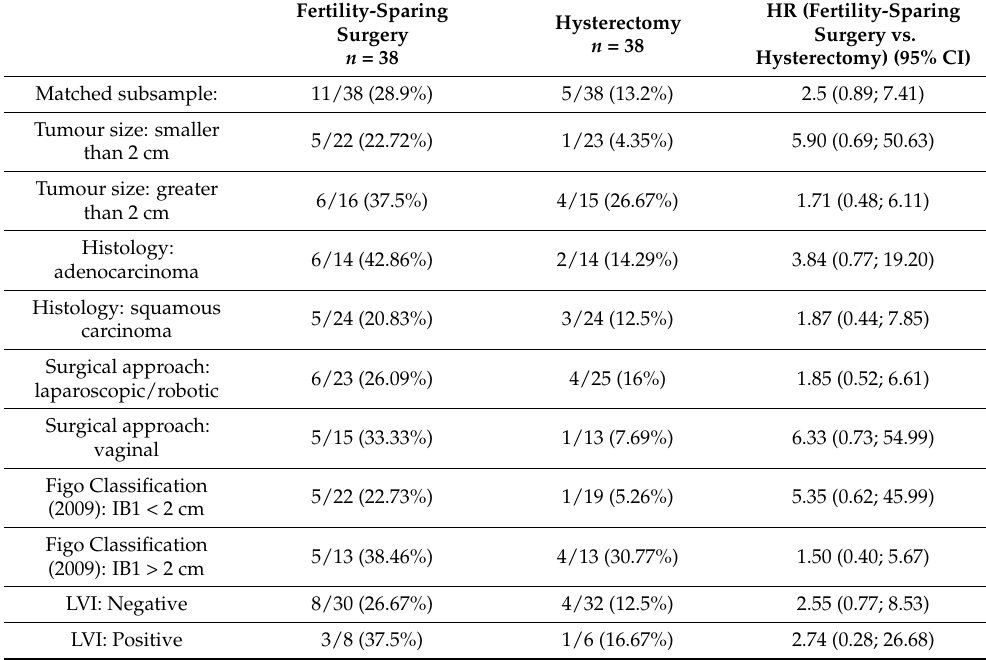
Table 5. Association between different factors and the disease-free survival time in each surgical group expressed in terms of hazard ratios and their 95% CIs.